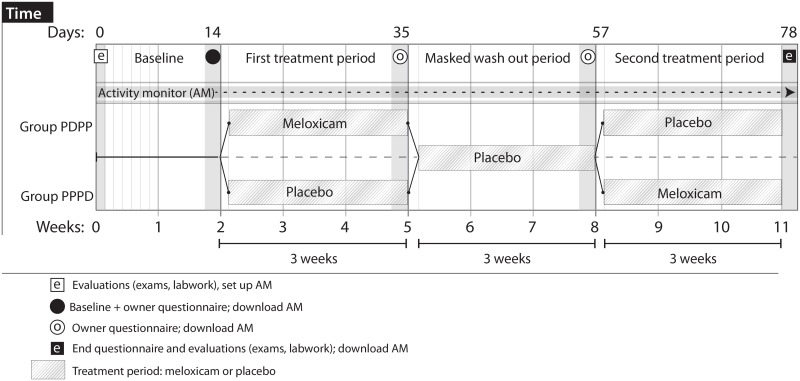
Study timeline and procedures completed at each timepoint.